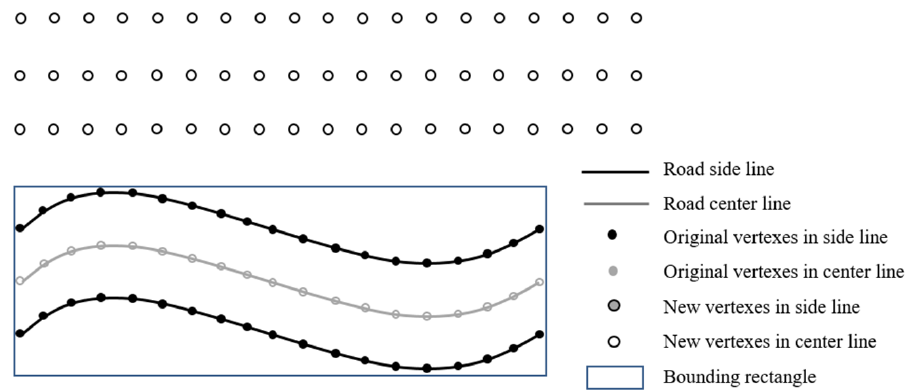
Figure 3. Elevation assignment process of the road skeleton line.